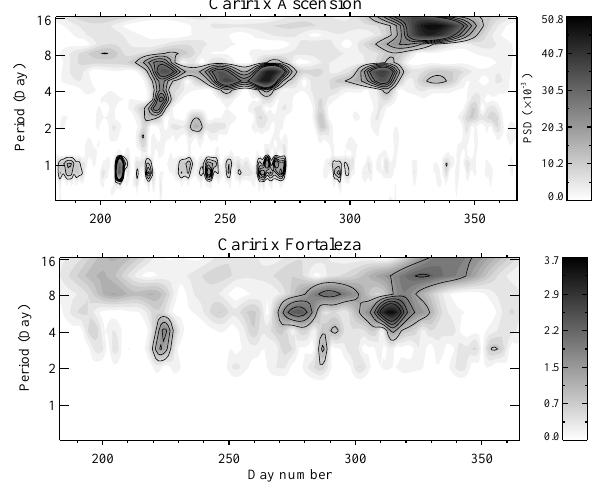
Fig. 5. Cross-wavelet power spectrum between the 90-km zonal winds at Cariri and Ascension Island (top), and between the MLT zonal wind at Cariri and the ionospheric h 0 F at Fortaleza (bottom). The full lines indicate the 90% significance